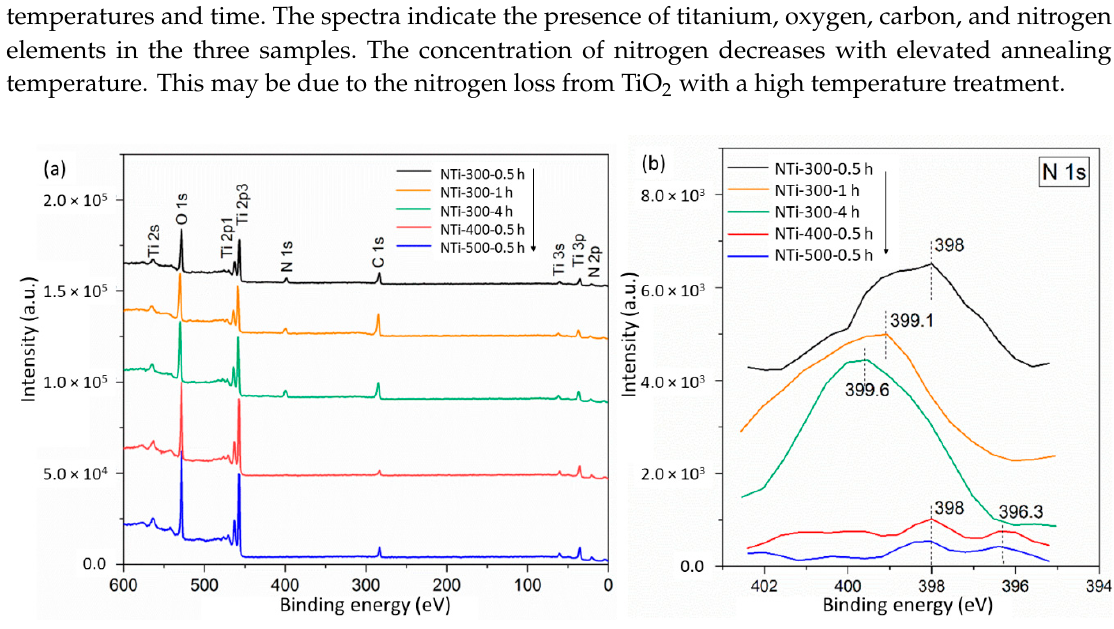
Figure 3. The XPS results of N-TiO 2 . ( a ) Full spectra and ( b ) N 1 s spectra. Black: NTi-300-0.5 h, Orange: NTi-300-1 h, Green: NTi-300-4 h, Red: NTi-400-0.5 h, Blue: NTi-500-0.5